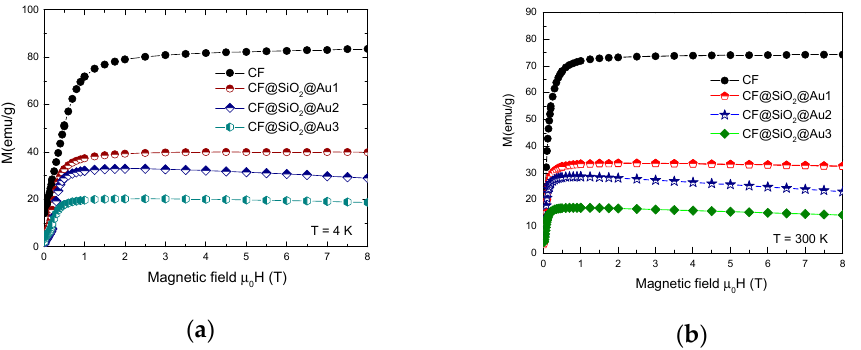
Figure 6. Magnetization isotherms at T = 4.2 K ( a ) and T = 300 K ( b ) of CoFe 2 O 4 and CoFe 2 O 4 @SiO 2 @Au nanocomposites.